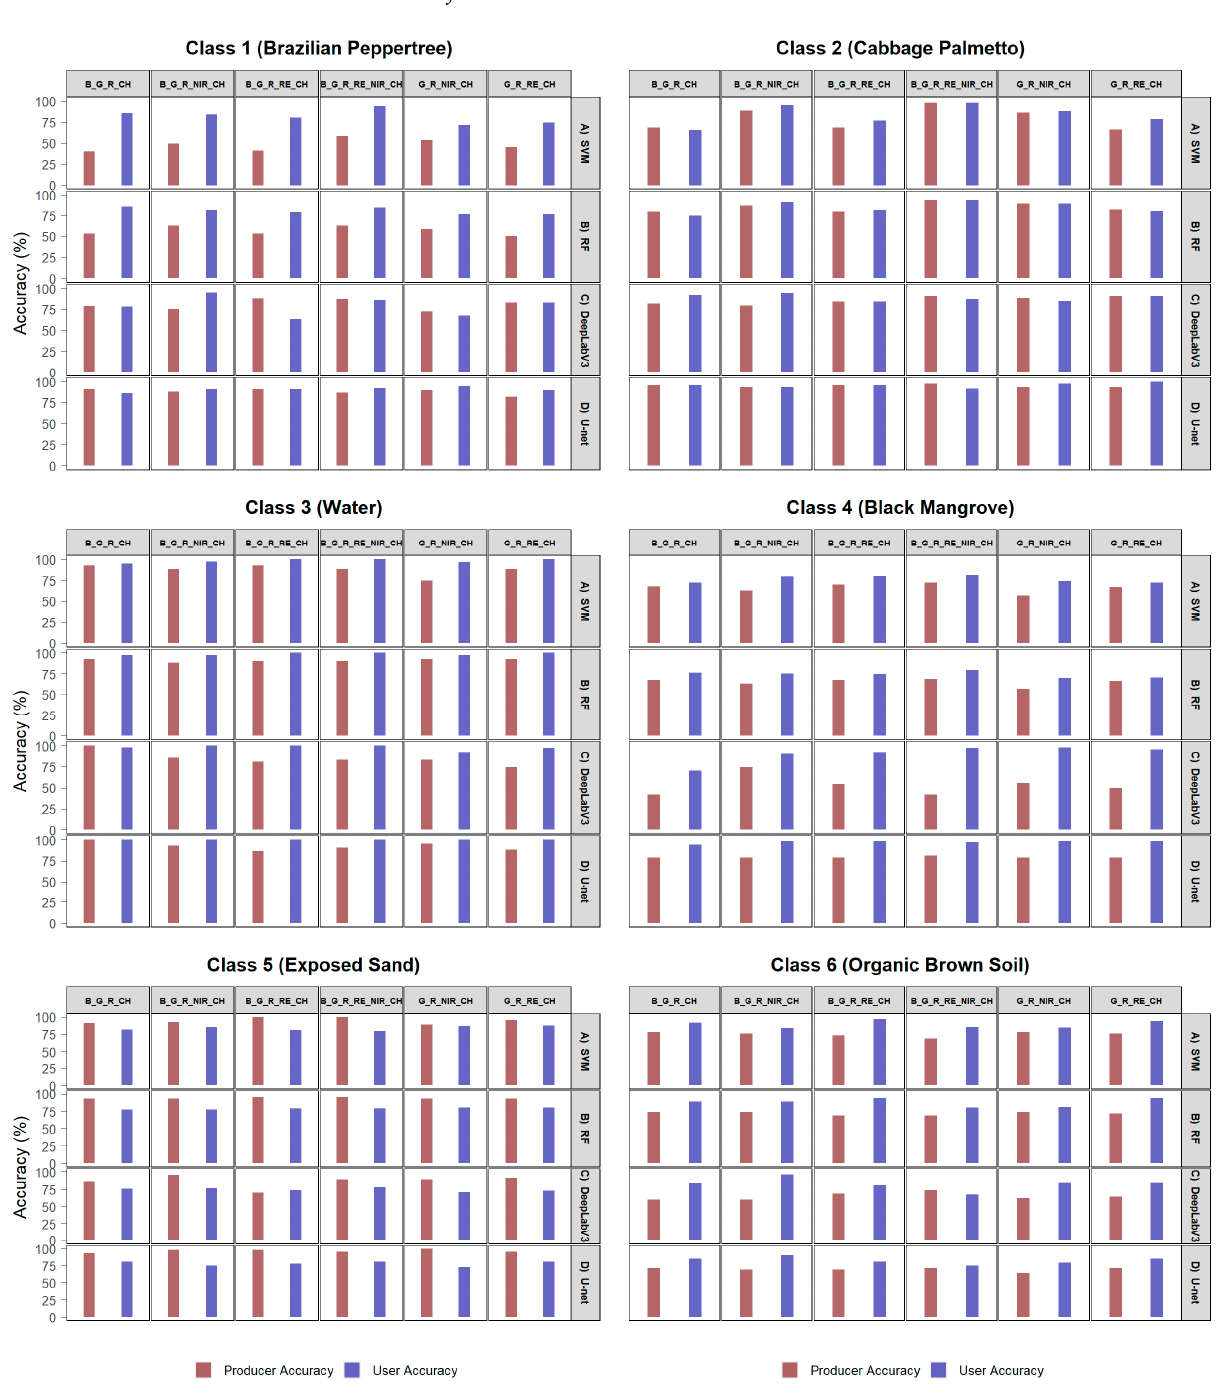
Figure A4. Experiment: EXP2-SB_AB_CHM, producer and user accuracy organized by class and classification method, classes 1 to 6.